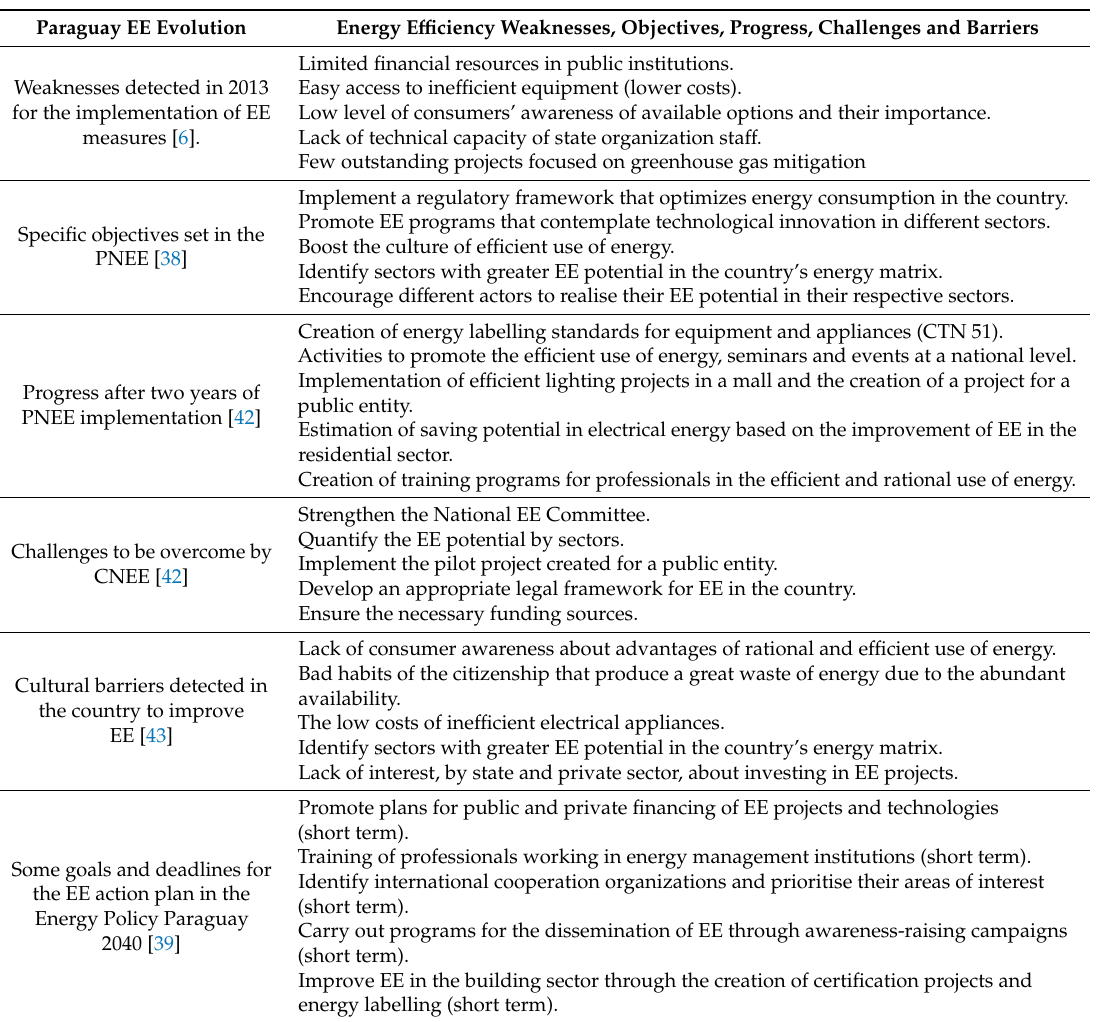
Table 1. Overview of energy e ffi ciency situation in